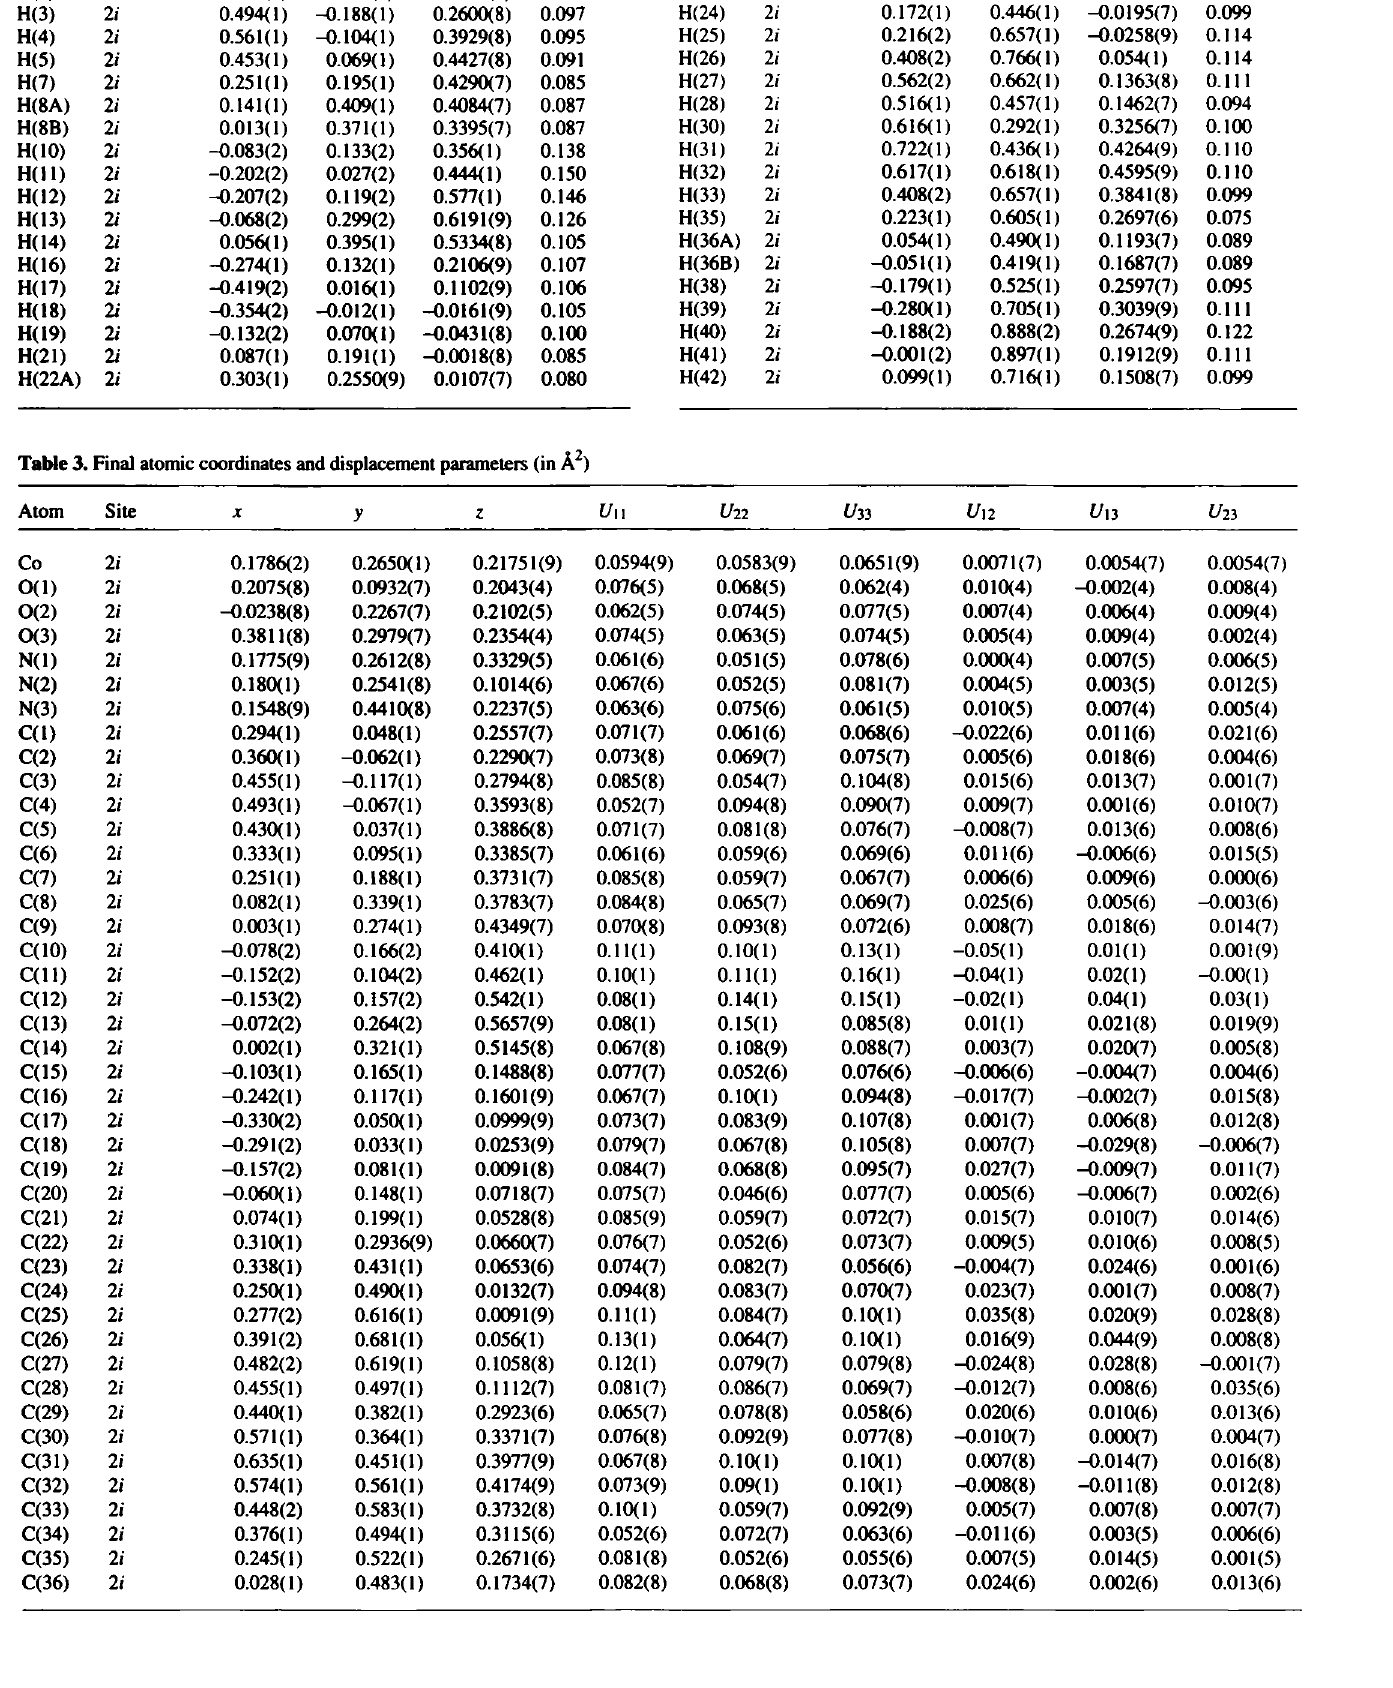
Table 3. Final atomic coordinates and displacement parameters (in Â 2